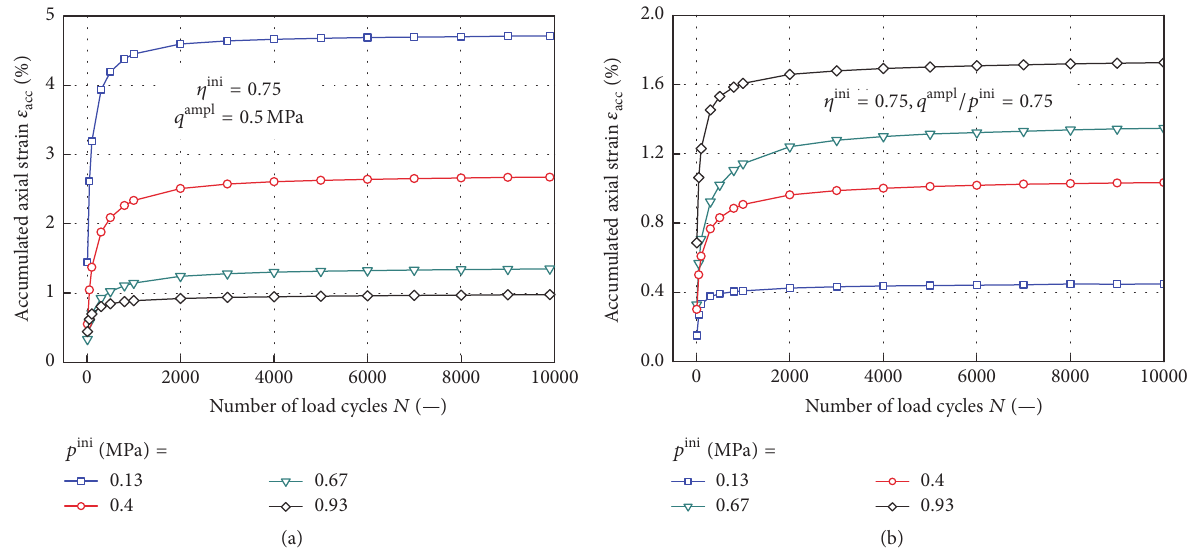
Figure 9: Test with different initial mean stress; accumulated axial strain versus number of load cycles: (a) cyclic stress amplitude 0.5 MPa; (b) 𝑞 ampl /𝑝 ini = 0.75